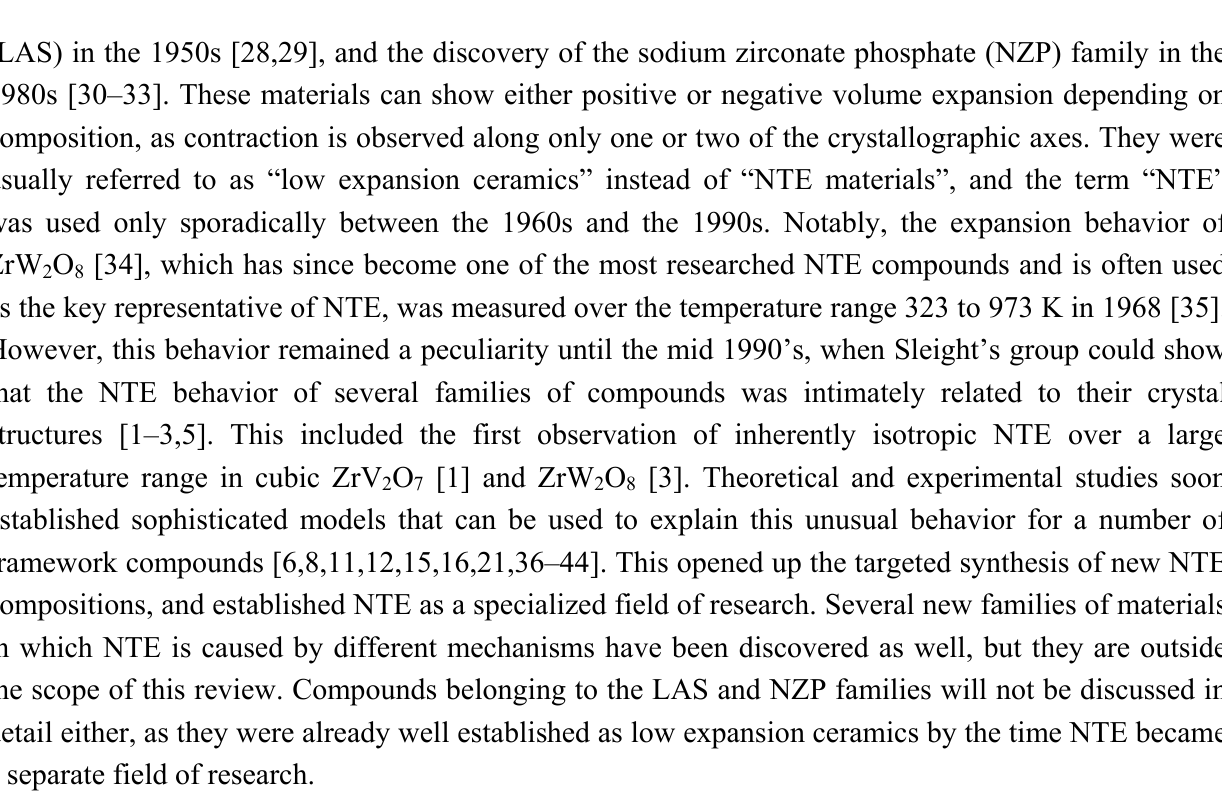
Figure 1. Number of publications per year based on a Web of Science search for “negative thermal expansion”. Note that early publications related to the field are missing as they did not use NTE as a